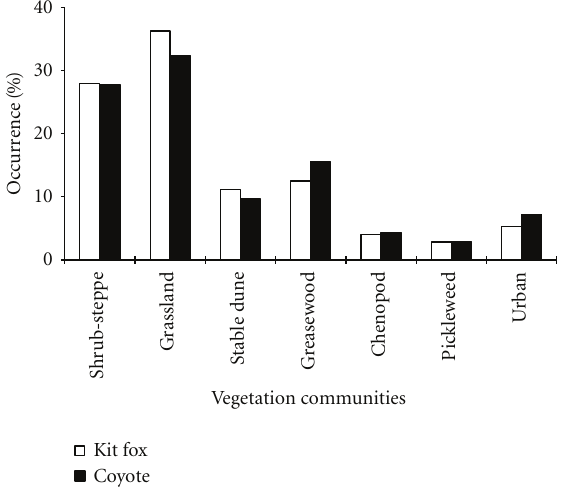
Figure 3: Predicted canid distributions for kit foxes and coyotes showing similar use of Dugway Proving Ground’s 7 habitat types, Utah,